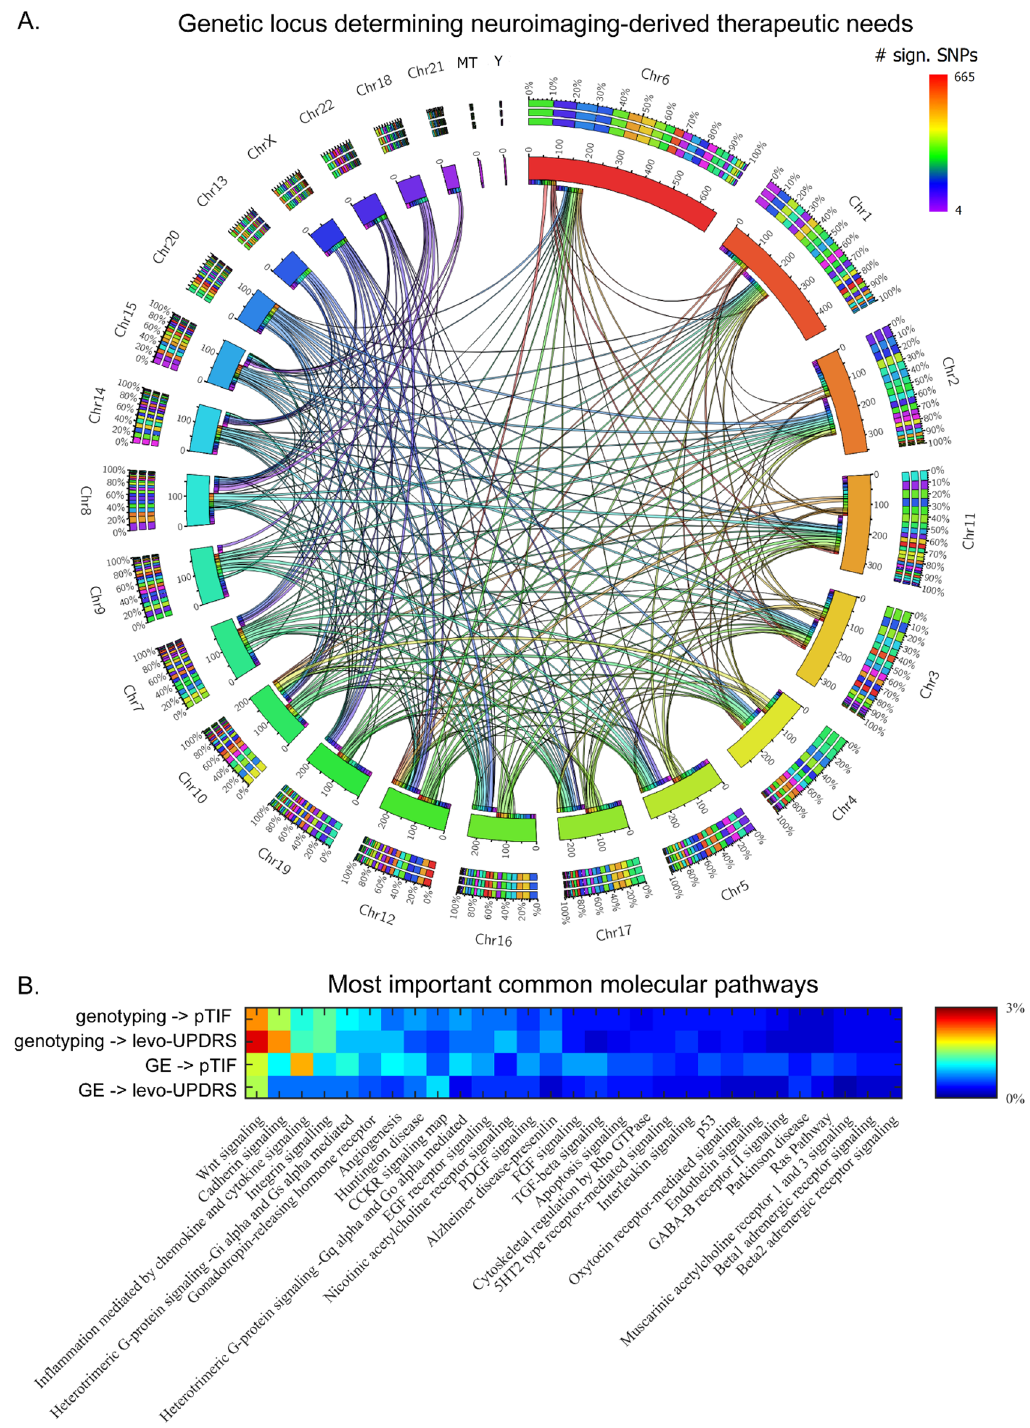
Figure 4. Genetic locus and molecular pathways determining neuroimaging-derived therapeutic needs in PD. ( A ) The circular plot shows the number of identified significant SNPs in each chromosome. The chromosome- chromosome links represent statistical similarity (correlation patterns) in modulation of the pTIF elements. ( B ) Top molecular pathways associated with the identified SNPs and transcripts predicting the pTIF elements and the clinical outcomes. Notice the high overlapping between the genomic and transcriptomic-based molecular predictors (see Table S2 for all the identified pathways and abbreviations